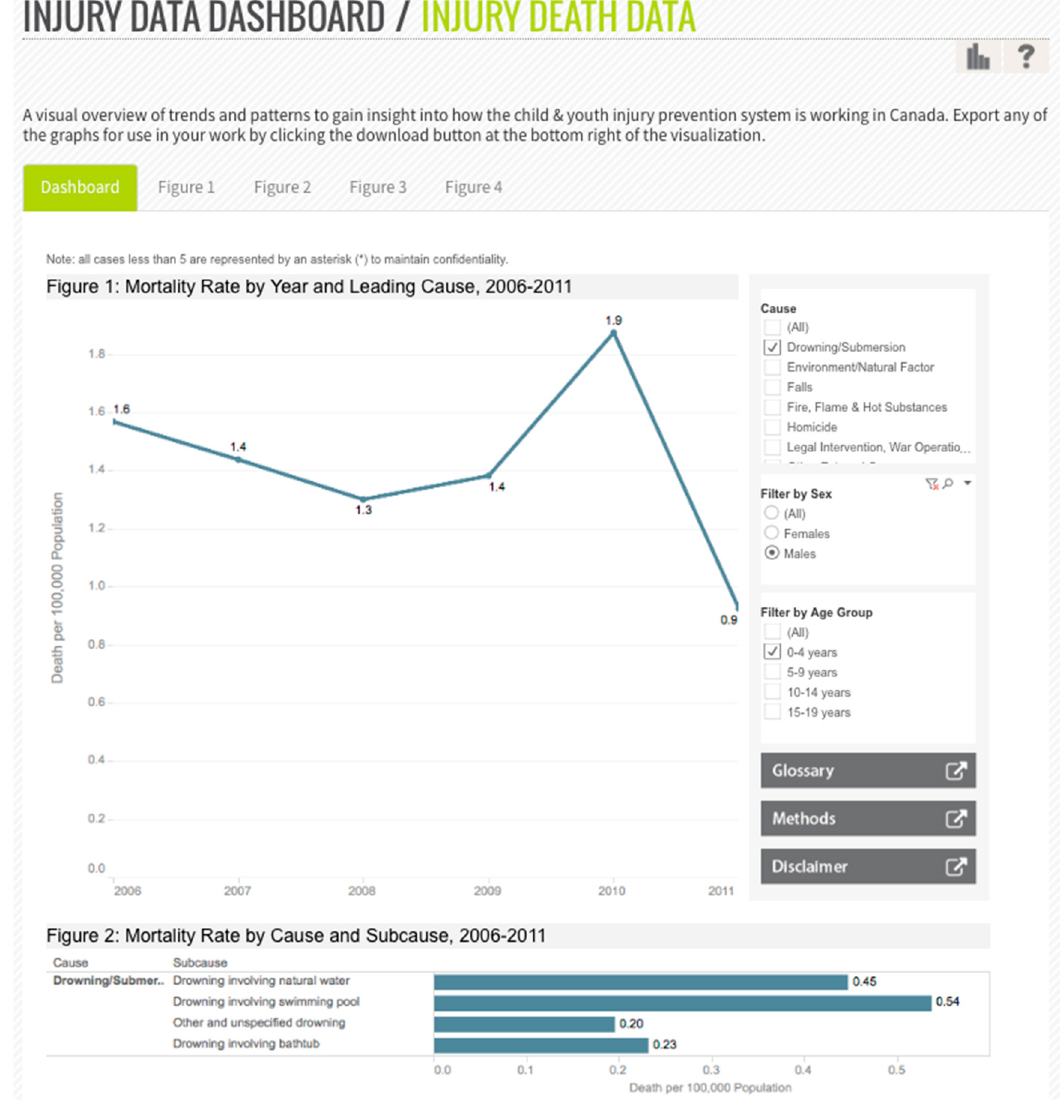
Figure 2. Dashboard output in graph display.